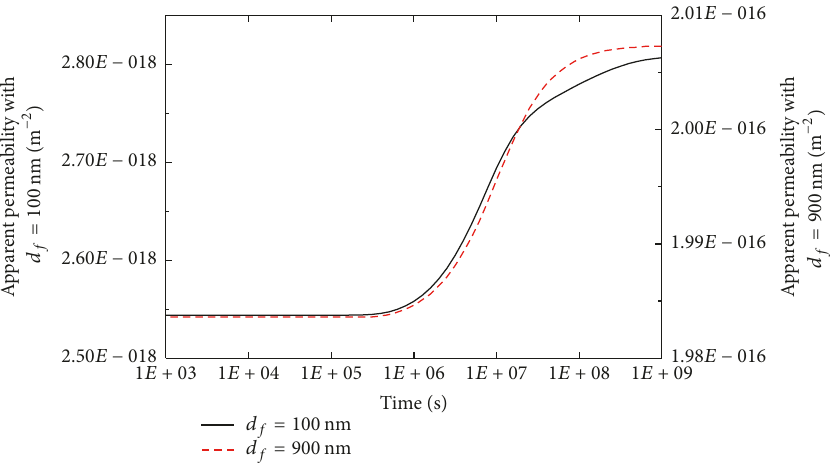
Figure 16: Evolution of apparent permeability with time under different